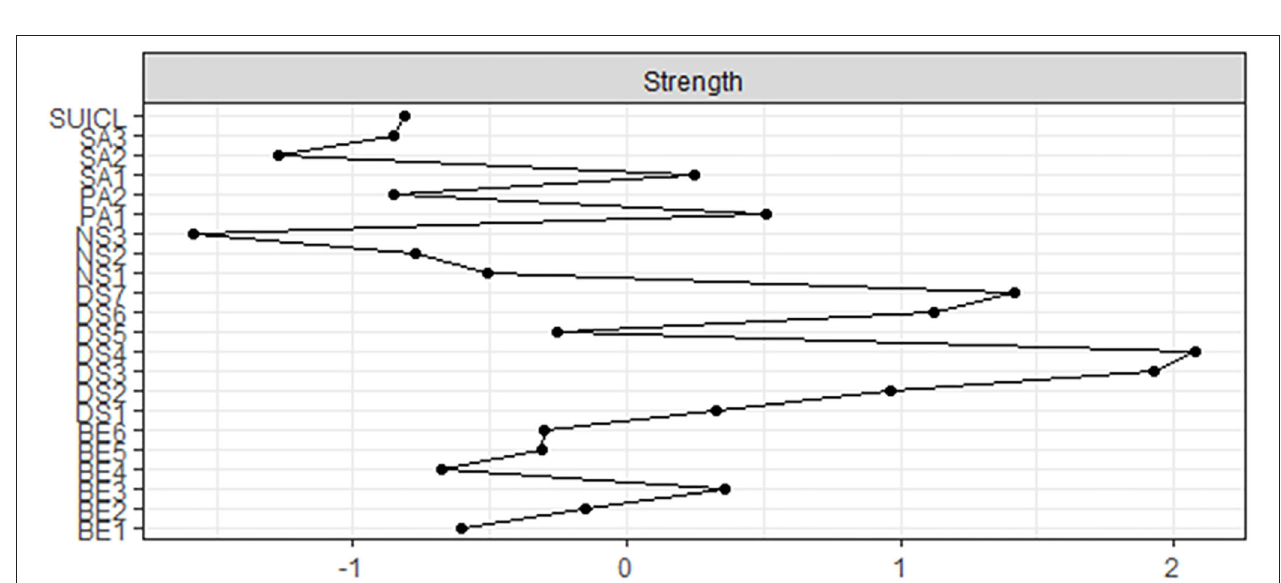
FIGURE 3 | Strength centrality values of nodes per